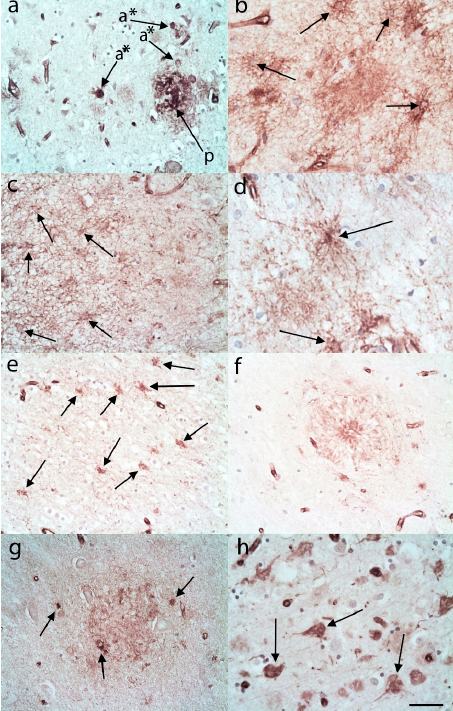
Figure 5. S100A10 immunohistochemistry in Alzheimer’s disease cases labelled in ( a ) the upper frontal cortex plaques ( p , arrows) and numerous ASLCs ( a* , arrows). ( b ) There were also numerous S100A10 immunopositive ASLCS not adjacent to plaques in the upper frontal cortex (arrows). ( c ) These S100A10 immunopositive ASLCs were also evident in the upper temporal cortex (arrows). ( d ) The lower frontal cortex revealed moderate to large numbers of S100A10 immunopositive ASLCs (arrows) and they were numerous in the frontal white matter ( e , arrows). Occasional S100A10 immunopositive plaques were evident in the CA4 region of the hippocampus ( f ). There were variable numbers of S100A10 immunopositive ASLCs also seen in this CA4 region of the hippocampus ( g , arrows). ( h ) S100A10 immunohistochemistry labelled occasional neurofibrillary tangles (arrows). Anti-S100A10. Original magnifications ( a – e ) and ( g ) × 40 (NA 0.9), ( f , h ) × 60 (NA 0.9). Scale Bar ( a ) − 75 µ m, ( b , d , e , g ) − 40 µ m, ( c , f , h ) − 50 µ